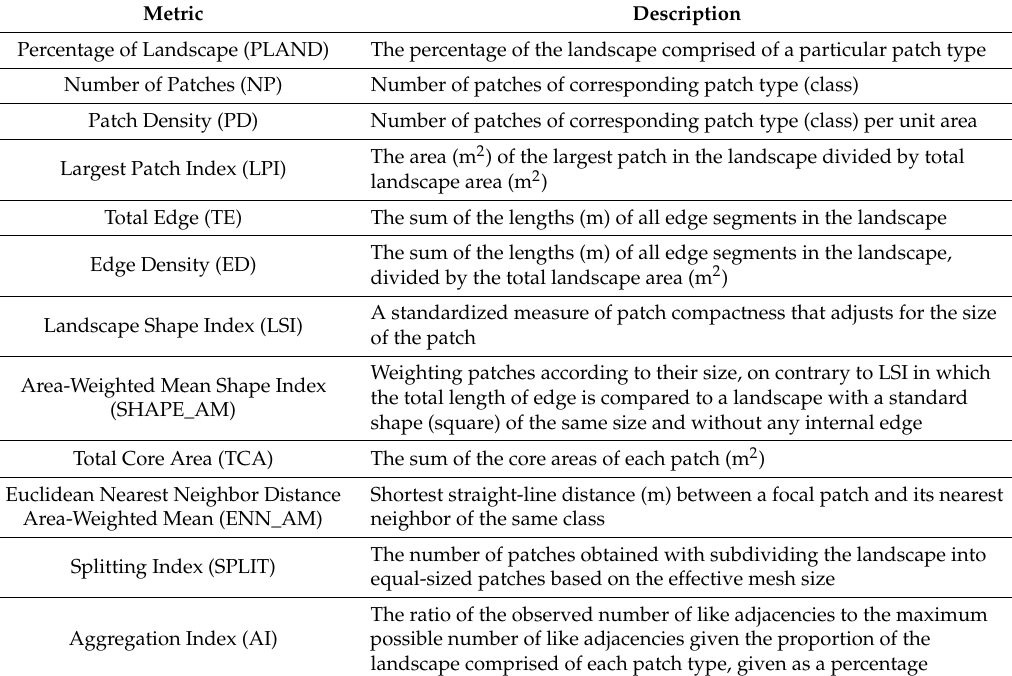
Table 5. Class metrics and descriptions